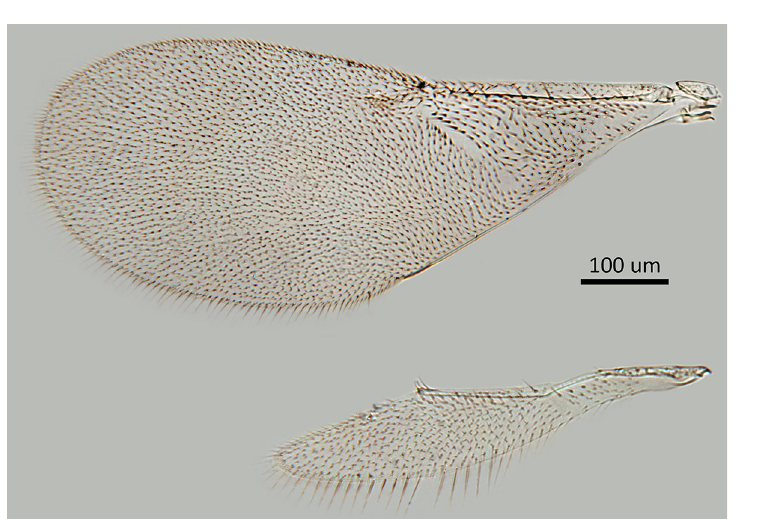
Fig 3. M . macadamiae female holotype, fore and hind wings.